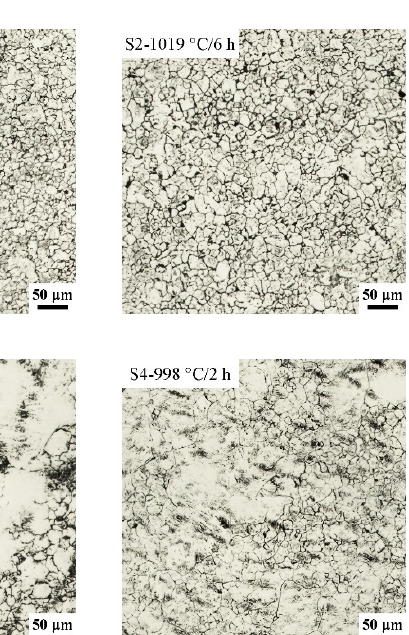
Figure 12. Calculated pinning strengths f p / r p (left, solid) and mass fractions (right, hollow) of the verified experiments. The cases are in the same sequence as in Table 4, and the black squares and red circles represent the fine and coarsened PAGSs, respectively.